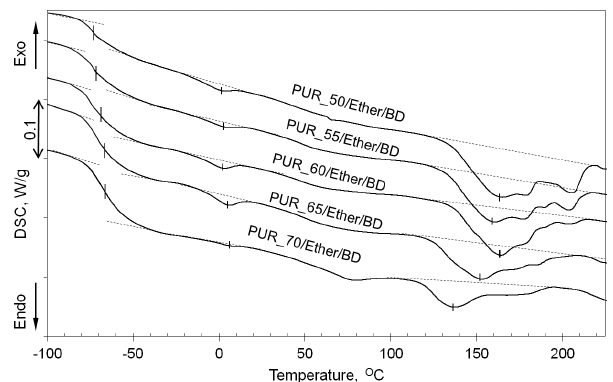
Figure 9. DSC curves of PUR with different contents of the polyether soft segment. First heating.